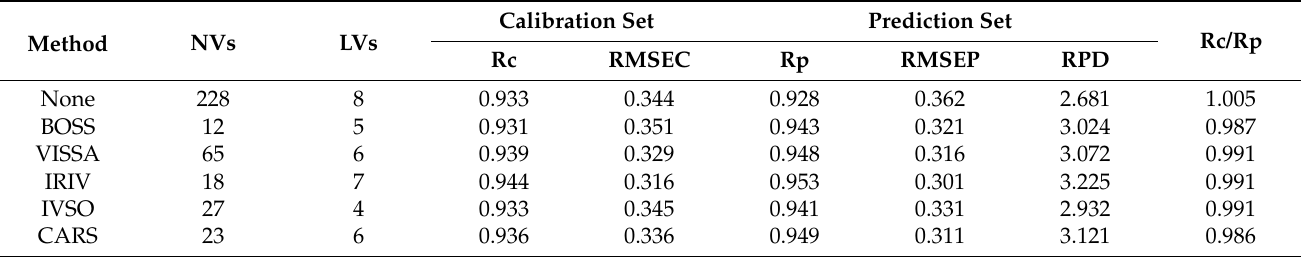
Table 2. Performance of PLSR models with different wavelength selection approaches for the prediction of fat